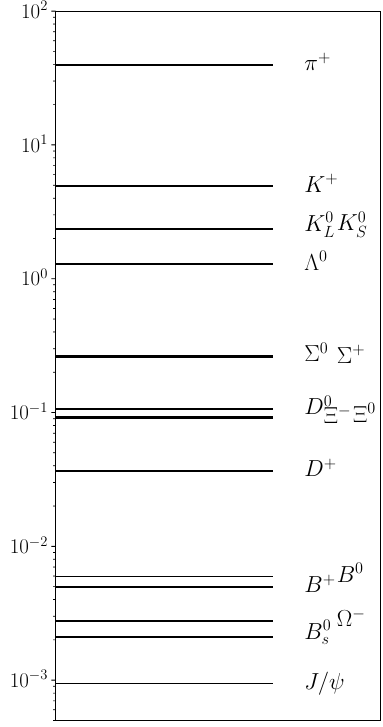
Figure 1 . Multiplicity of particles produced in a single pp interaction at p s = 13 TeV within LHCb